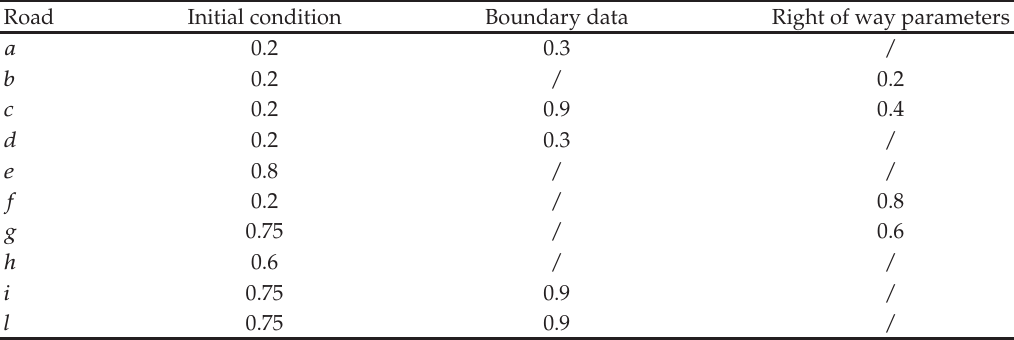
Table 1: Initial conditions, boundary data and right of way parameters for roads of the network. Road Initial condition Boundary data Right of way